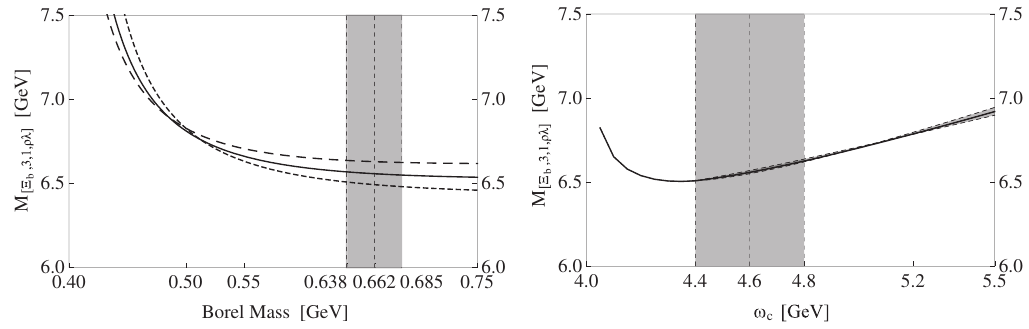
Figure 4. The variation of m Ξ as a function of the Borel mass T ( left ) and the threshold value b ( 5/2 + ) ω c ( right ). In the left panel, the short-dashed, solid, and long-dashed curves are obtained by setting ω c = 4.4, 4.6, and 4.8 GeV, respectively. In the right panel the shady band is obtained by varying T within the Borel window. These figures are plotted for the bottom baryon doublet [ Ξ b ( ¯3 F ) ,3,1, ρλ ]